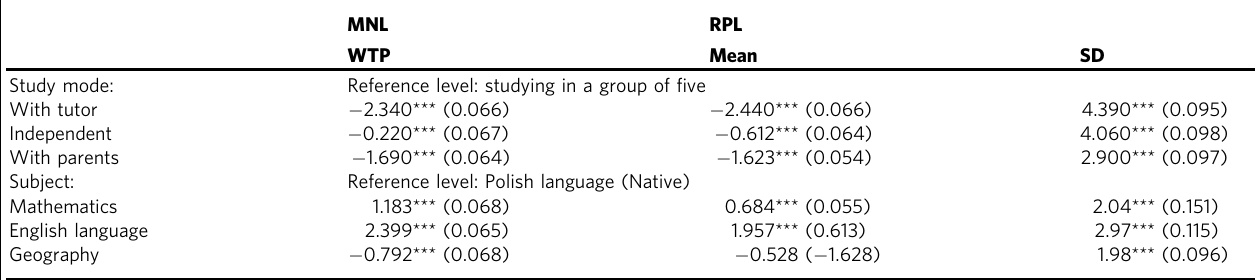
Table 2 Willingness to pay calculated based on multinomial logistic regression estimates and mixed logit model in willingness to pay space.